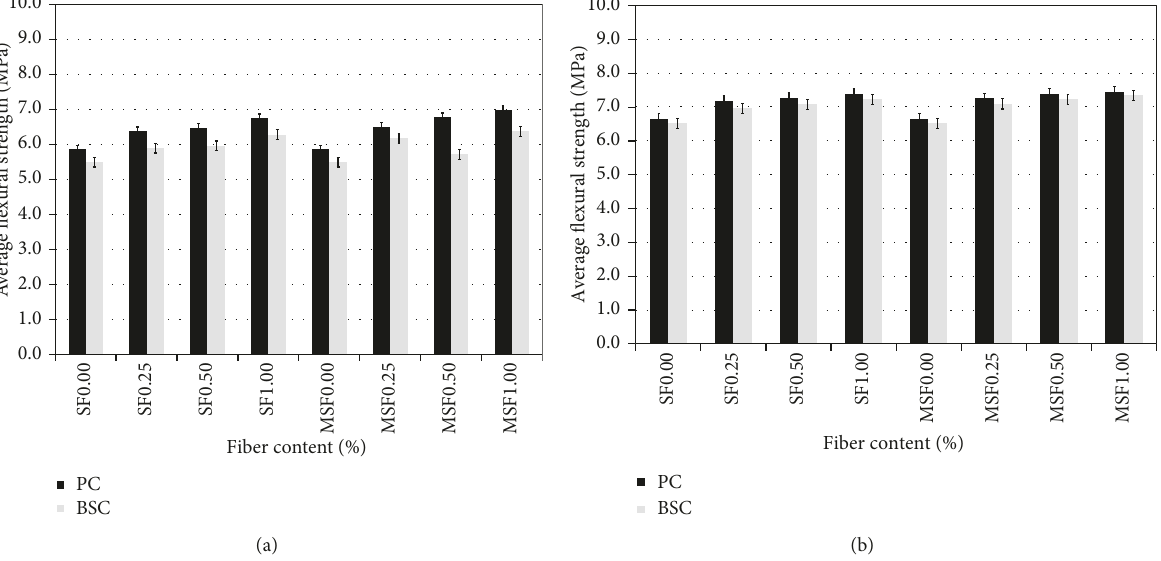
Figure 10: Flexural strength with fiber volume fraction. (a) Target strength 40MPa. (b) Target strength